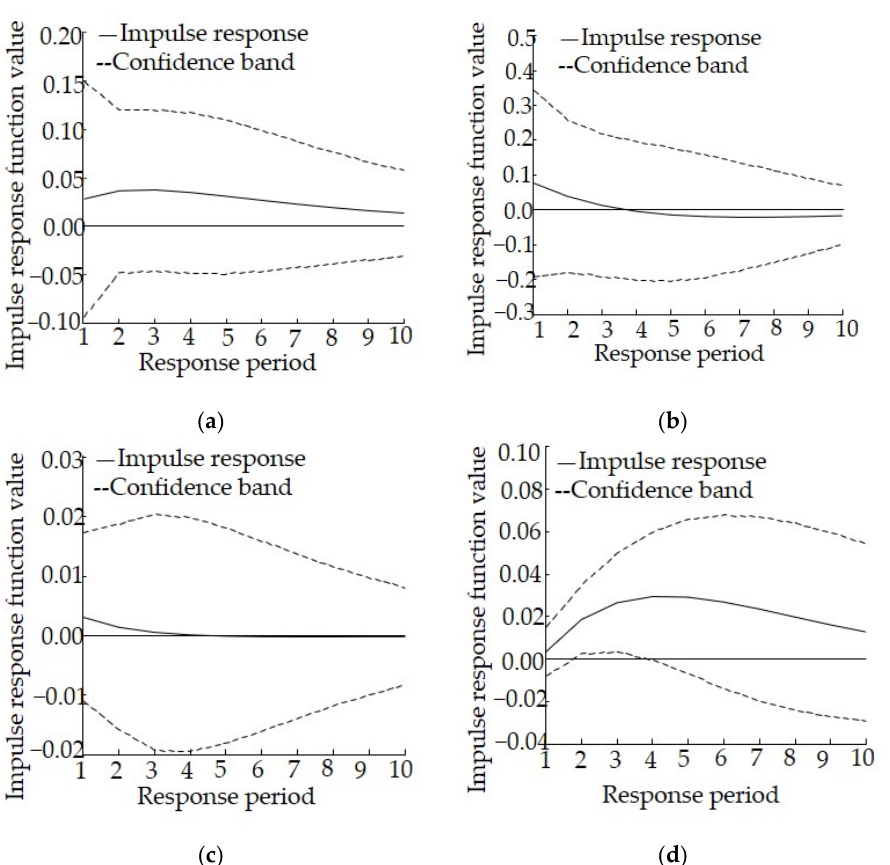
Figure 5. Impulse response relationship between industrial structure adjustment and the discharge of pollutants to the aquatic environment in Ningxia, ( a ) Impulse response of lnCOD to lnSI, ( b ) Impulse response of lnAN to lnSI, ( c ) Impulse response of lnSI to lnCOD, ( d ) Impulse response of lnSI to lnAN. The results of the variance decomposition analysis for Ningxia are shown in Table